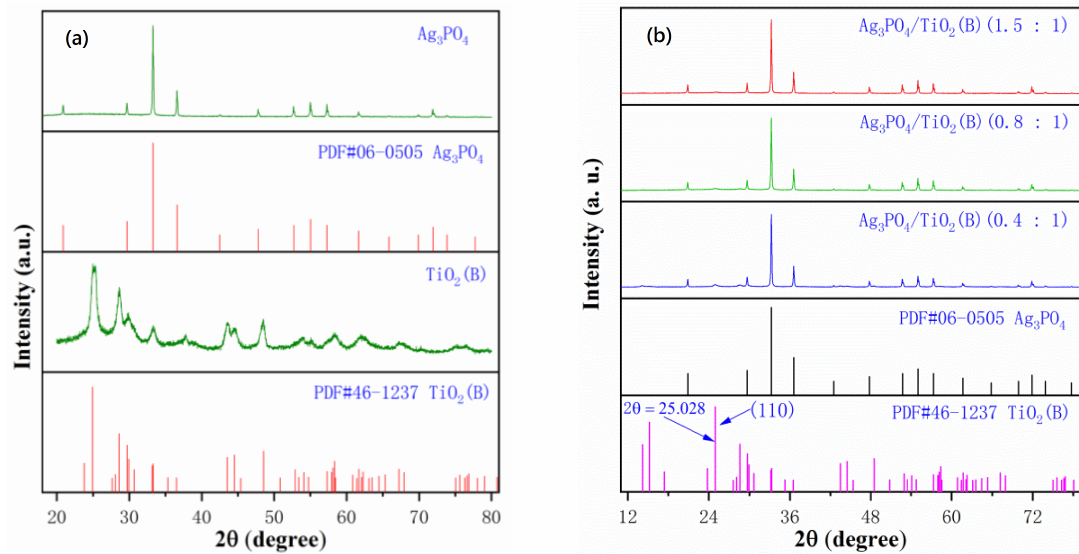
Figure 3. XRD patterns of synthesized samples. Figure 3. ( a ) XRD patterns of Ag 3 PO 4 and TiO 2 (B); ( b ) XRD patterns of Ag 3 PO 4 /TiO 2 (B) with different molar